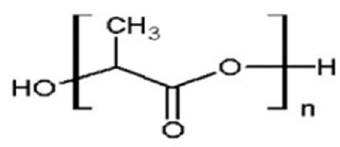
Figure 10. The chemical structure of PLA.